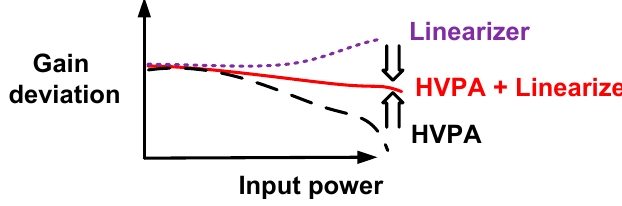
Figure 1. Gain deviation of HVPA with and without the linearizer as a function of input power. Linearizer techniques have been widely researched in RF communication applications